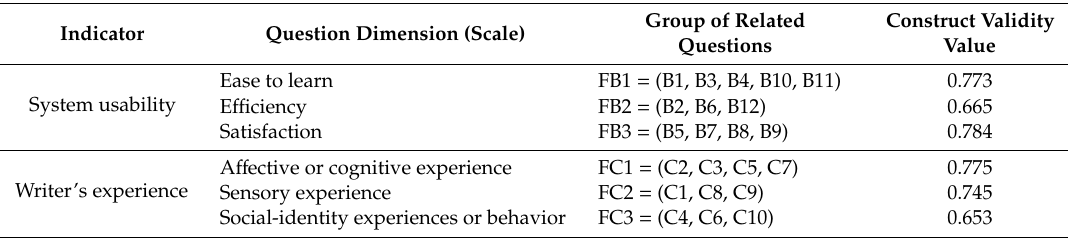
Table 17. Construct validity values of the question dimensions (scales) of the two indicators of “system usability” and “writer’s experience” yielded by the CFA. Question Dimension